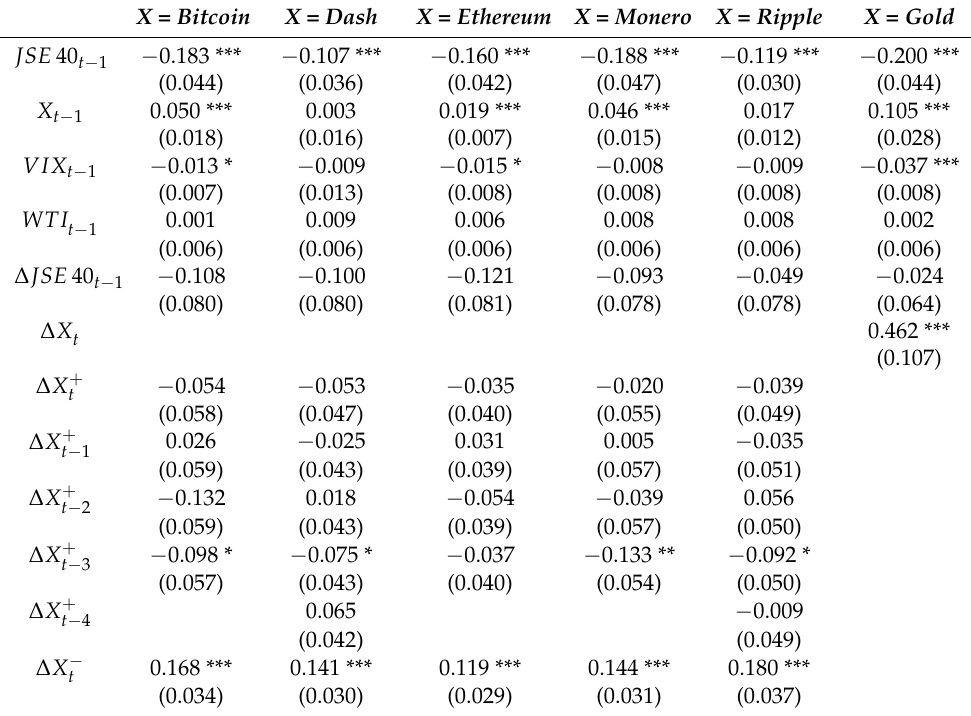
Table 12. Estimation results for JSE 40 during COVID-19.